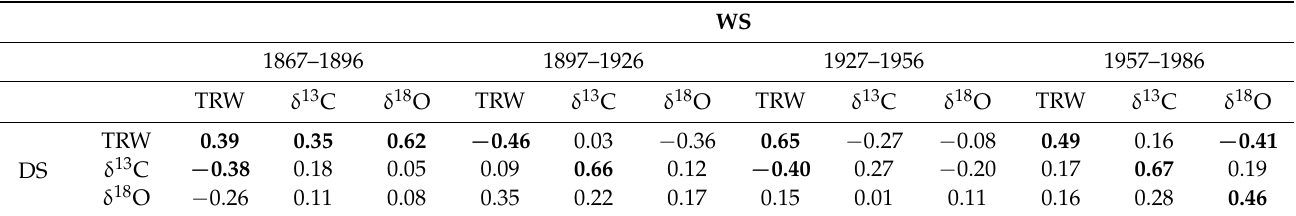
Figure 4. Running correlation between the two sites (WS and DS) for TRW (black line), δ 13 C (blue line) and δ 18 O (red line) chronologies applying a 30—years window (vertical dotted line indicates the fire event in 1896 at DS). The horizontal dotted lines indicate the threshold for significance at p < 0.05 (r = 0.19, n = 113). Table 2. Correlation coefficients (bold numbers are significant at p < 0.05) between all chronologies of DS and WS for the four selected periods before and after fire 1896 (30 years each).